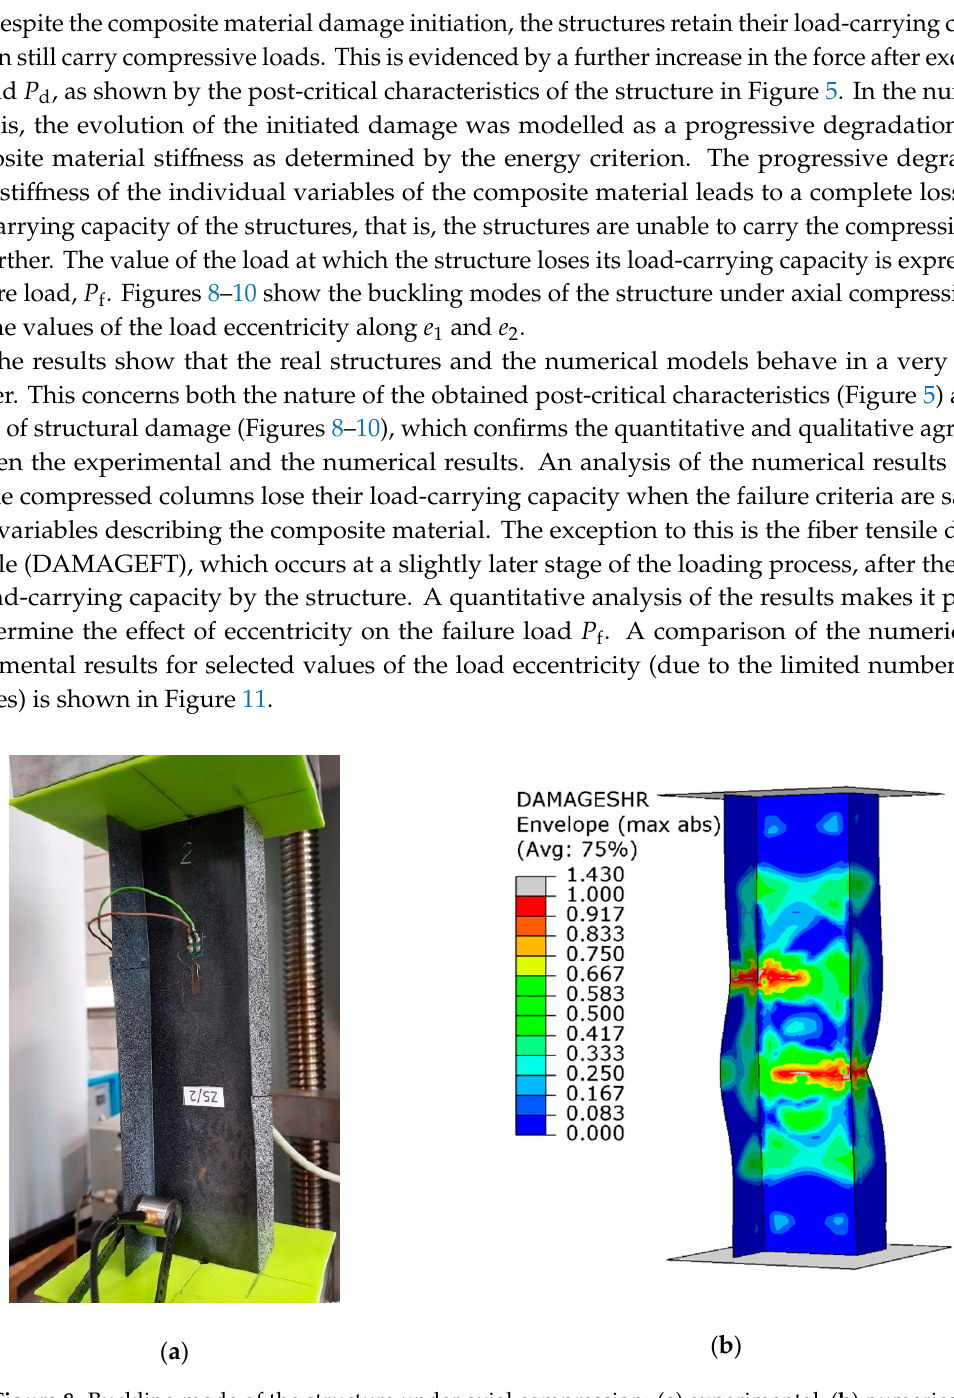
Table 2. Composite material damage initiation load P d versus eccentricity.